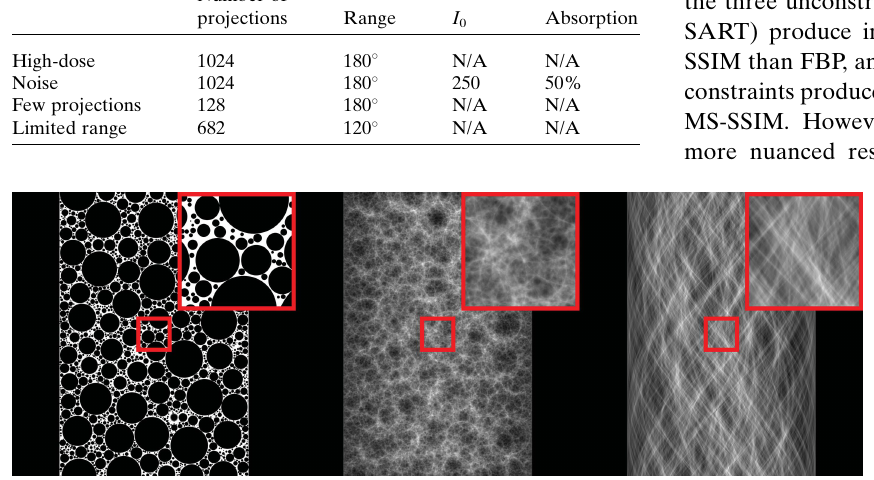
Figure 7 Example of the generation of parallel-beam projection data. Shown are the central sagittal ( i.e. vertical) slice of a foam phantom (left), a parallel-beam projection of the phantom (middle), and a sinogram of the central axial ( i.e. horizontal) slice (right). A small region, indicated in red, is shown enlarged in the top right corner of each